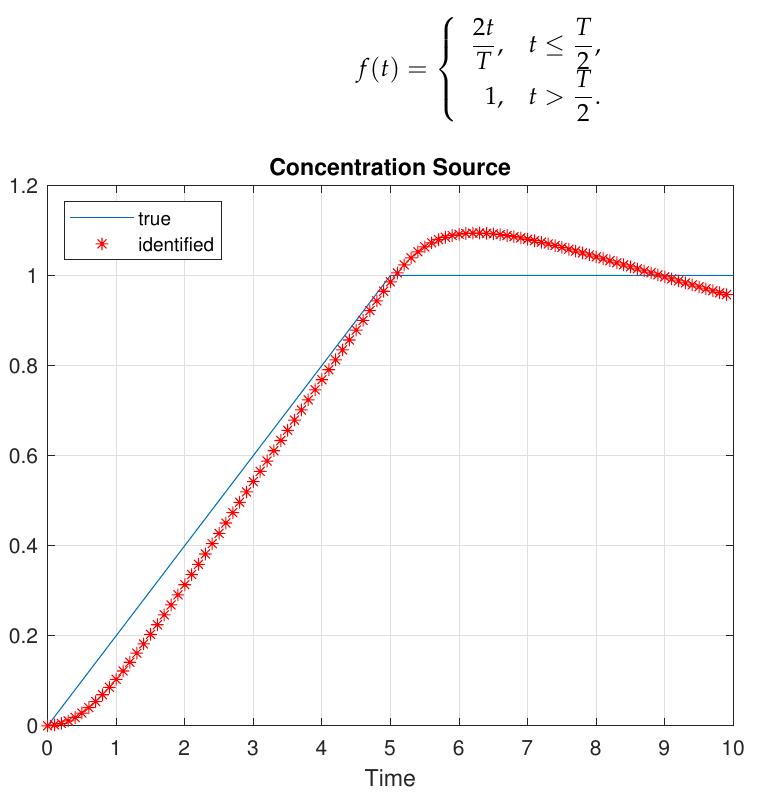
Figure 4. True and recovered values of the concentration source